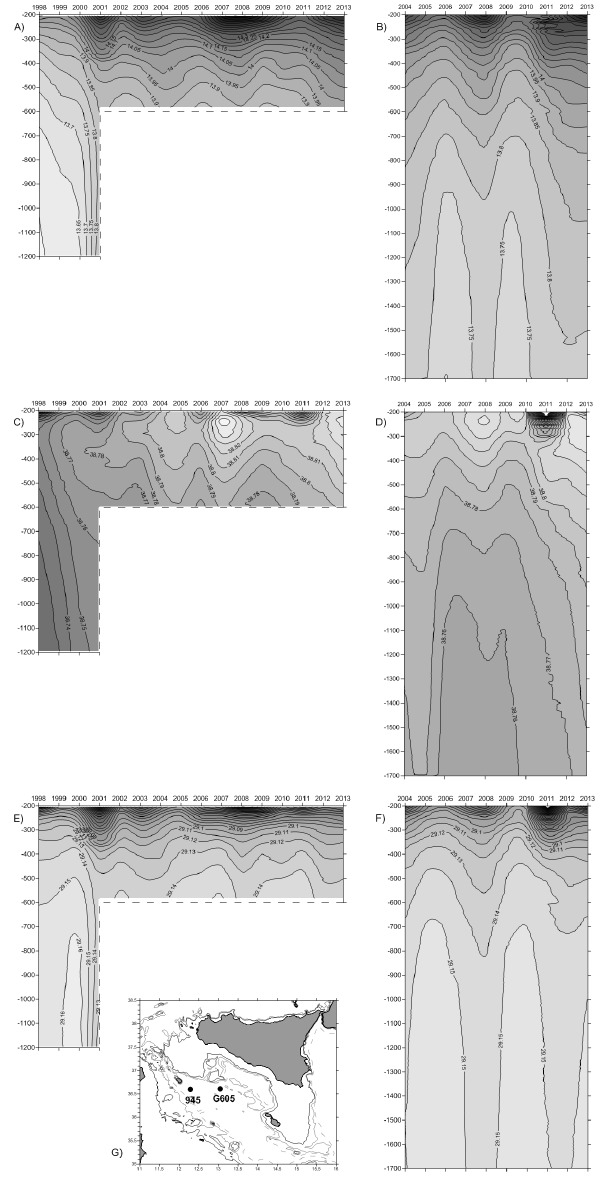
Figure 9. Hovmöller diagrams of potential temperature (a) , salin- ity (c) and potential density (e) in the layer 200–1200m in the sta- tion 945 (1200m) for the period 1998–2013. Hovmöller diagrams of potential temperature (b) , salinity (d) and potential density (f) in the layer 200–1700m in the station G605 (1700m) for the period 2003–2013. (e) Map with the position of the stations 945 and